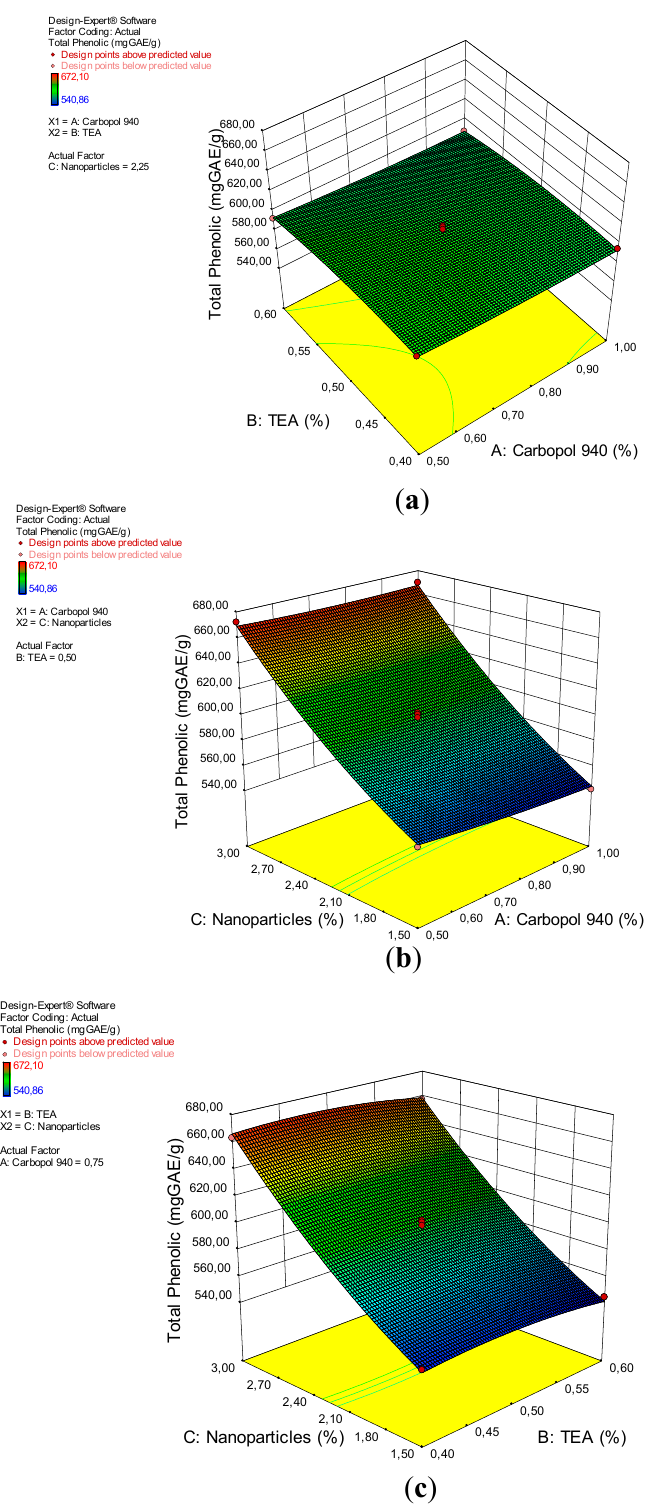
Figure 6. A 3D plot of the relationship between ( a ) carbopol 940 and TEA and the total phenolic content, ( b ) carbopol 940 and nanoparticles and the total phenolic content, and ( c ) TEA and nanoparticles and the total phenolic content.